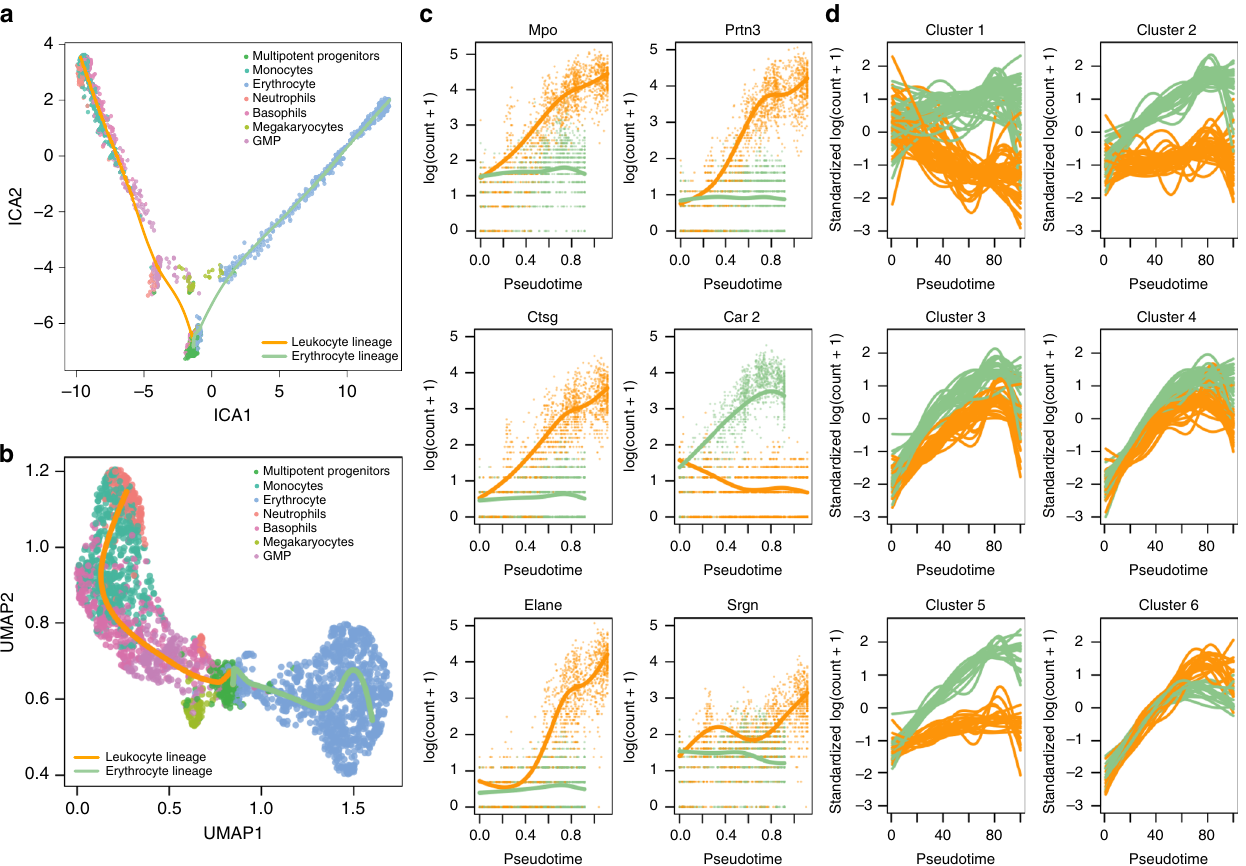
Fig. 5 Mouse bone marrow case study. a Two-dimensional representation of a subset of the data using independent components analysis (ICA). The myeloid trajectory inferred by slingshot is displayed. b Two-dimensional representation of a subset of the data using UMAP. The myeloid trajectory inferred by slingshot is displayed. The UMAP dimensionality reduction method better captures the smooth differentiation process than ICA. c Estimated smoothers for the top six genes identi fi ed by the tradeSeq patternTest procedure on the trajectory from ( b ). d Six clusters for the top 500 genes with different expression patterns between the two lineages (as identi fi ed by patternTest from